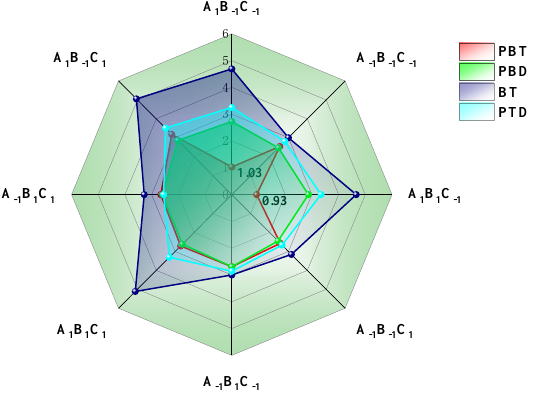
Figure 6. Radar chart of blade optimization.